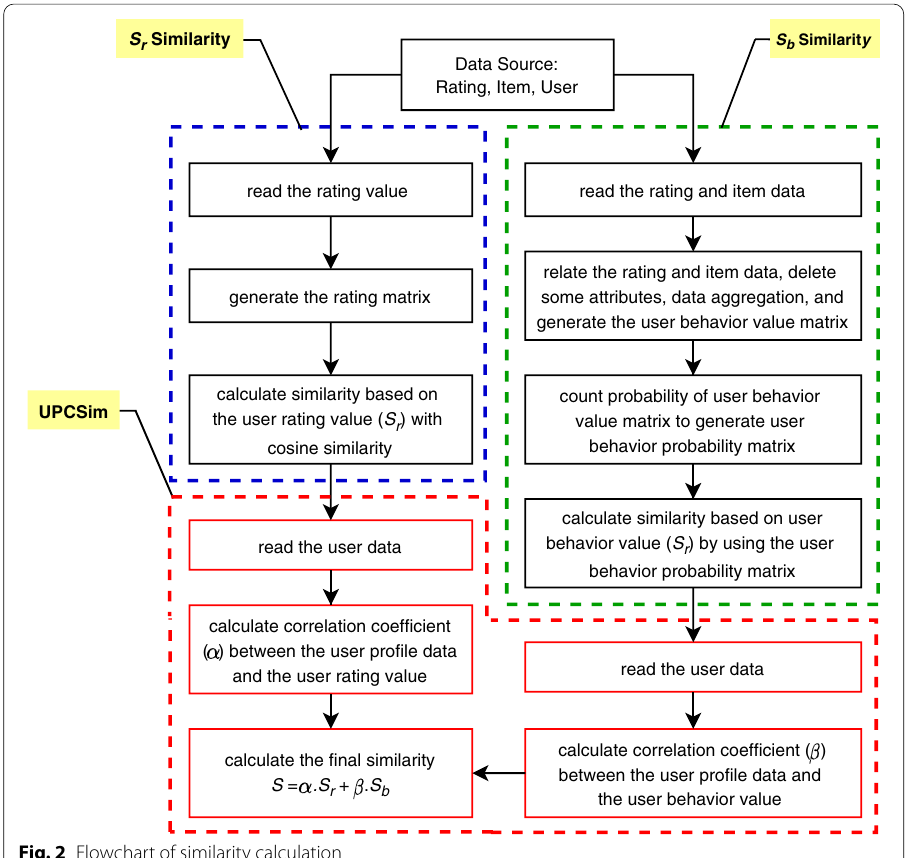
Fig. 2 Flowchart of similarity